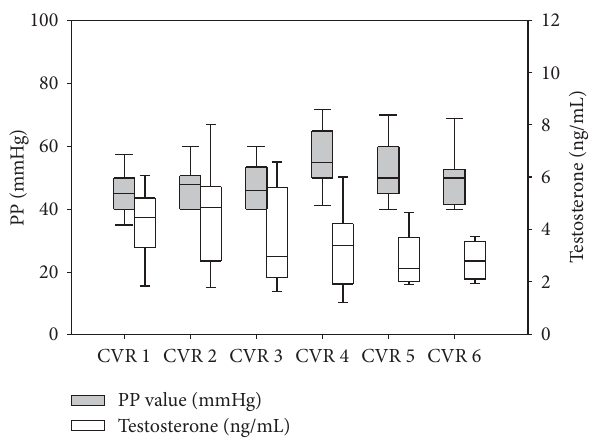
Figure4:Pulsepressureandserumtestosteronestratifiedaccording to cardiovascular risk.